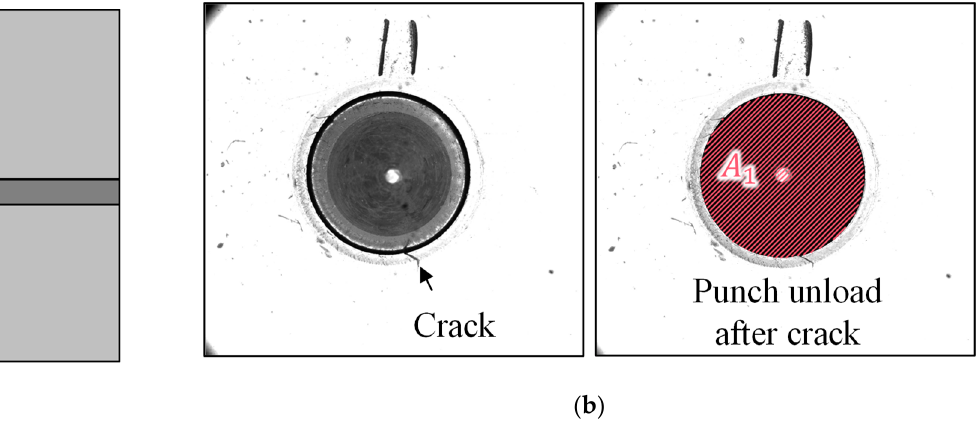
Figure 7. HET process: ( a ) schematic of HET and ( b ) area measurement after crack occurrence.